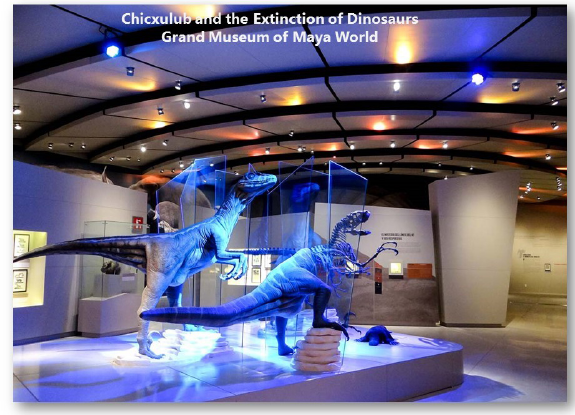
Figure 6. Partial view of displays of the exhibition on Chicxulub and the extinction of dinosaurs in the Gran Museo Mundo Maya in Mérida,